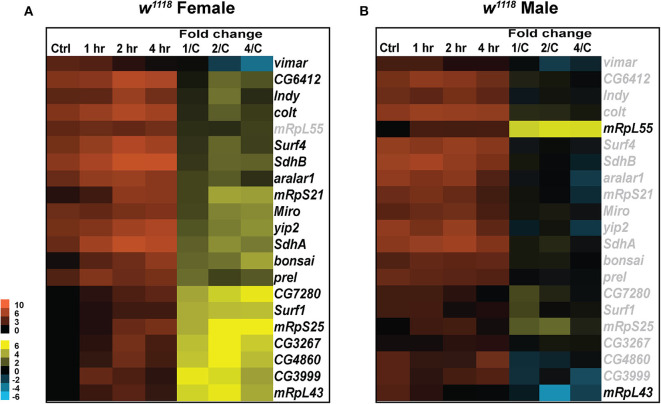
Mitochondrial gene expression changes after injury. Heatmaps depicting expression changes in mitochondria related genes for females (A) and males (B) at control, 1, 2, and 4 hr after injury. Orange scale represents the average of normalized counts for 3 replicates in each group indicated above. Yellow-blue scale shows fold change for each gene at 1, 2-, and 4-hr post-injury compared to control. 1/C, fold change at 1-hr compared to control; 2/C, fold change at 2-hr compared to control; and 4/C, fold change at 4-hr compared to control. All genes indicated in black font are significant (|log2FC| > 1, p < 0.05).